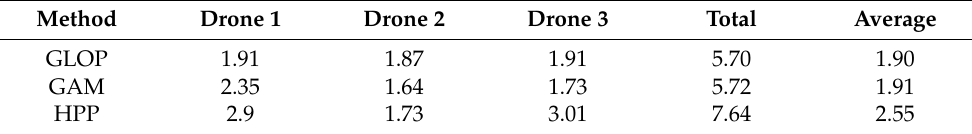
Table 7. Simulated SIU Route